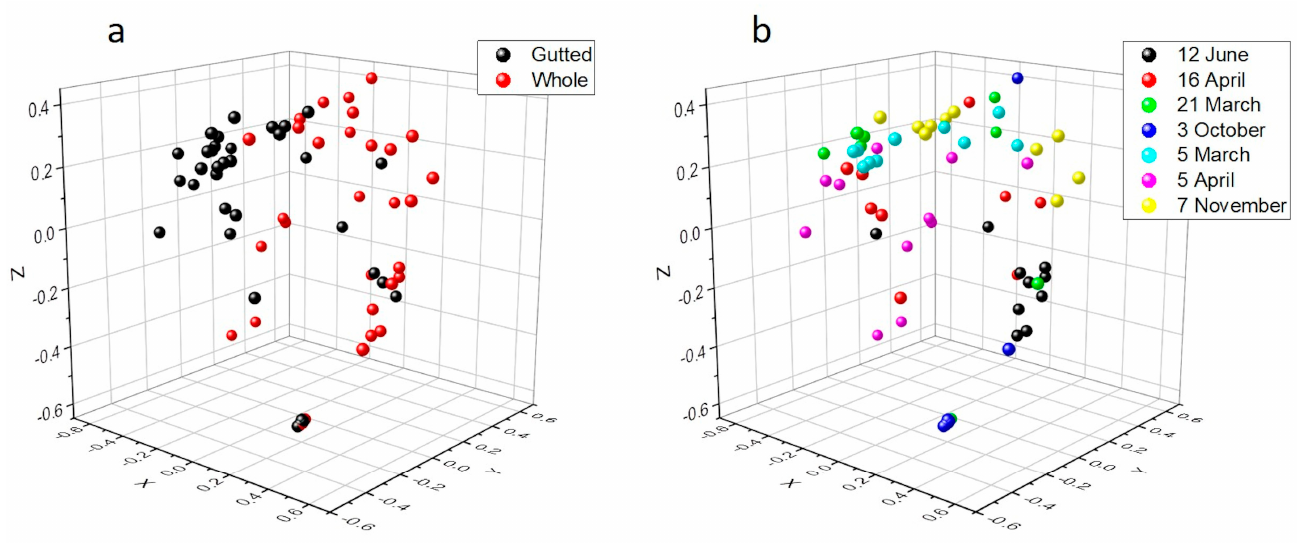
Figure 3. Non-metric multidimensional scaling (NMDS) plot of the OTUs of the whole and gutted herring calculated with the Thetayc distance matrix by the gutting treatment ( a ) and the sampling date ( b ), with 97% similarity threshold. The lowest stress is 0.15 and R 2 0.86. In most of the samples, the majority of the sequences (71.7% to 95.0%) were assigned to the phyla Actinobacteria, Firmicutes, and Proteobacteria (Figure 4). An exception was the 3 October batch, where their share was only 37.5% and 26.1% in the whole and gutted herring, respectively. The dominant phylum observed in this batch was Epsilonbacteraeota, which accounted for up to 72.0% of all sequences. The phylum was present in all other samples as well, yet with lower abundance. Together, these four main phyla made up 92.7% to 98.6% of the bacterial population at all sampling points. The majority of the re- maining less than 8% of all sequences were assigned to phyla Bacteroidetes, Cyanobacteria, and